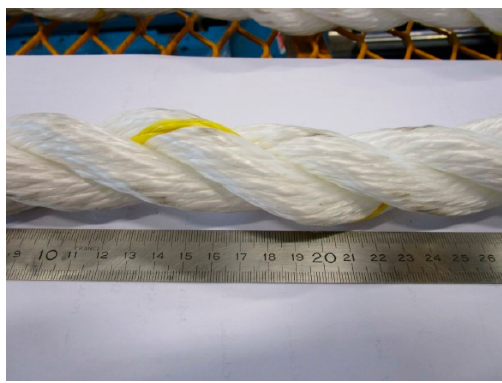
Table 2. Rope construction displaying the elements and material properties of the test sample.